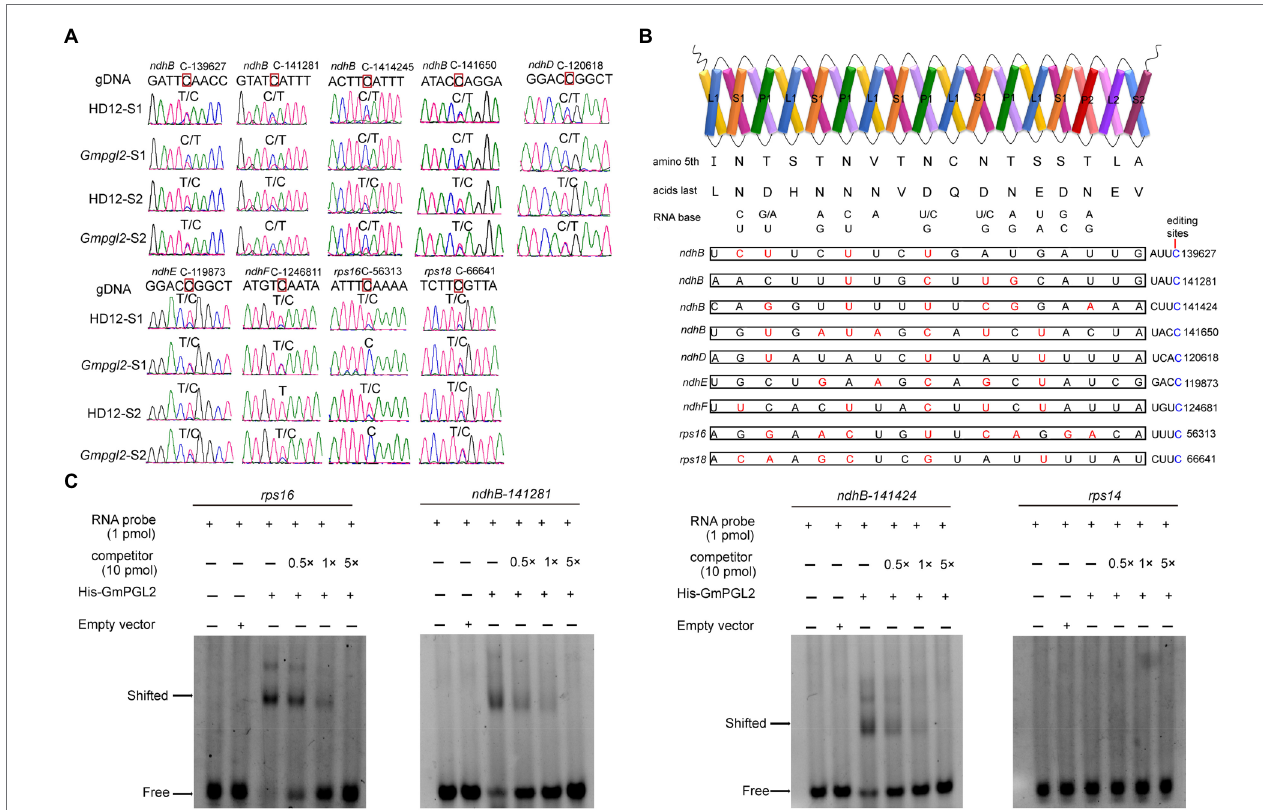
FIGURE 4 | Analysis of GmPGL2 targeted genes and their interactions. (A) RNA editing sites validated by sequencing of the RT-PCR products. Green, black, red, and blue peaks represent A, G, T, and C, respectively. S1, leaves of 12-day-old seedlings; S2, leaves of 18-day-old seedlings. The names of the RNA editing sites are shown on top of the chromatograms. The edited bases are indicated by red square. (B) Schematic representation of GmPGL2 bound to its target sites. The combinations of positions 5 and last amino acid in each PPR motif of GmPGL2 were aligned to the nucleotide upstream of the editing site. Permissible matched nucleotides are indicated in red, and the edited sites C are indicated in blue. (C) REMSA of GmPGL2 protein with its target probes, rps16 , and ndhB -141281, 141424. rps14 probe was served as a negative